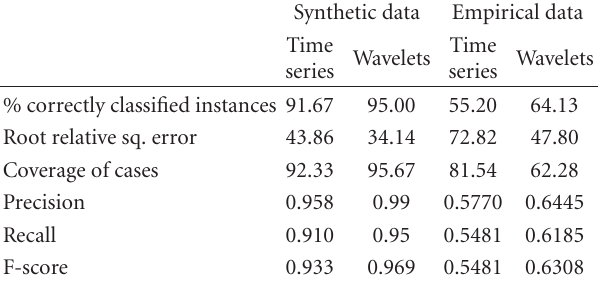
Table 3: Classification accuracy by the two